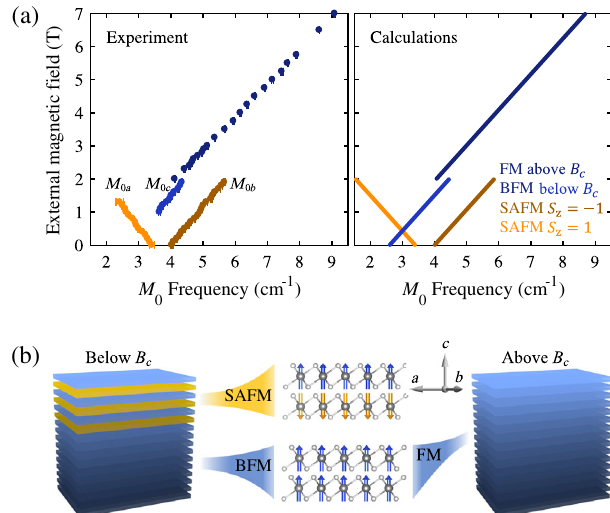
FIG. 2. Establishing the mixed SAFM and BFM phase in 3D CrI 3 . (a) Experimental data (left) and spin-wave calculations (right) for the magnetic field dependence of M 0 -type mode frequencies. M 0 , M 0 , and M 0 label the three spin-wave a b c branches below the critical magnetic field B of 2 T. Error bars c correspond to one standard error of the fitted central frequencies for the M 0 -type Raman modes and are mostly smaller than the data point symbols. (b) Schematic illustration of the mixed state of the surface-layered AFM (SAFM for the state with alternating spin moments in the adjacent layers) and the deep bulk FM (BFM for the state with all the spin moments along one direction) below B and the pure FM state above B c c